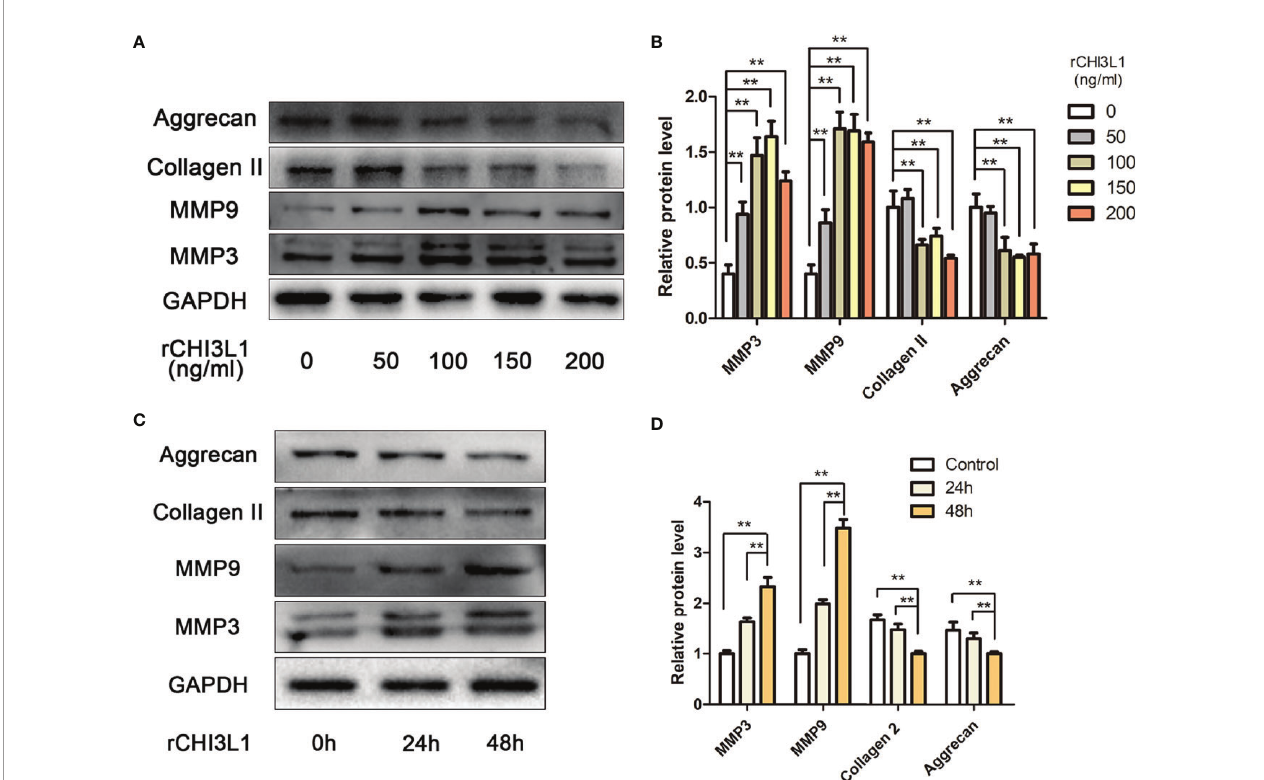
FIGURE 4 | rCHI3L1 promoted ECM metabolism in NP cells. (A) Effects of rCHI3L1 concentration gradient on ECM metabolism in NP cells. Following incubation with different doses of rCHI3L1 for 48 h, the protein levels of MMP3, MMP9, collagen II and aggrecan in NP cells were detected by western blotting. (B) Quanti fi cation of the protein levels in (A, C) Effects of rCHI3L1 on ECM metabolism at different time points. NP cells were treated with rCHI3L1 (150 ng/ml) for 24 or 48 h. The protein levels of MMP3, MMP9, collagen II and aggrecan were detected by western blotting. (D) Quanti fi cation of the protein levels in (C) Data are presented as means ± standard deviations (n = 3) from one representative experiment of three independent experiments performed in triplicate. The dates were analyzed by One-way analysis of variance (ANOVA). Signi fi cant differences between groups are shown as **p <